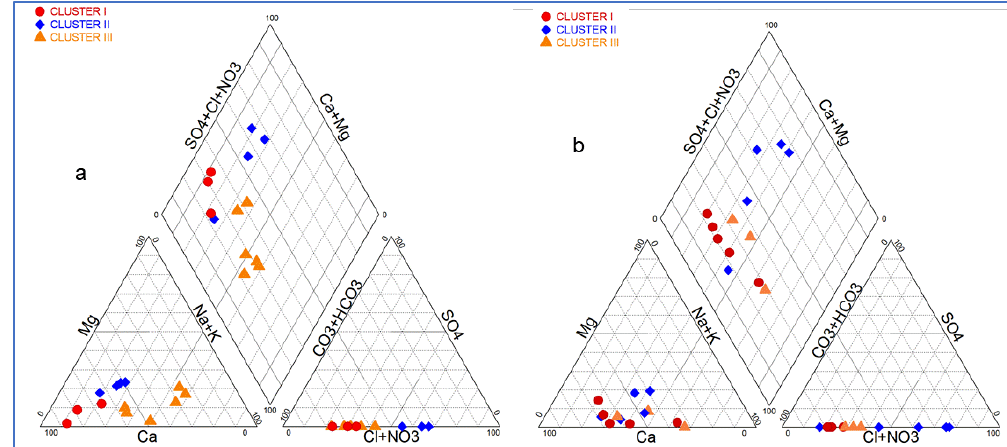
Figure 12. Piper diagram: ( a ) low water and ( b ) high water.